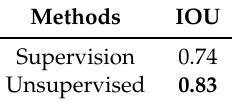
Table 4. Test results for ground segmentation using our network structure with or without